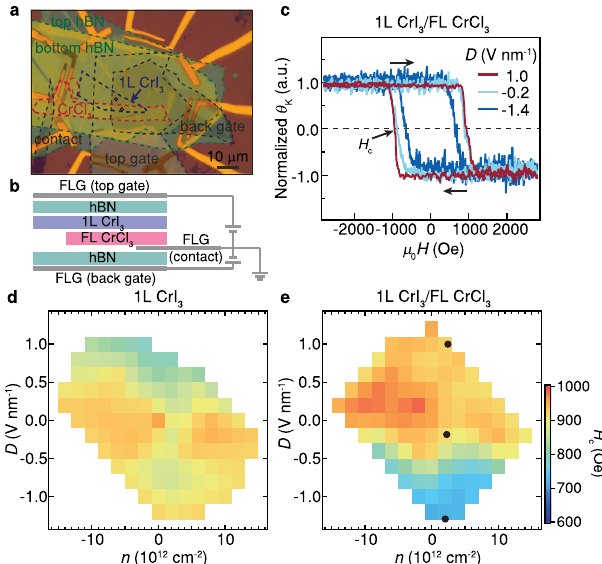
Fig. 3 | Electricalcontrolofthe magnetism in 1L CrI 3 /FL CrCl 3 heterostructure. a , b Optical micrograph and schematic structure of a dual-gated 1L CrI 3 /FL CrCl 3 device. Three few-layer graphene (FLG) fl akes are used as back/top gates and the contact to the stack. c Normalized MOKE signal as a function of perpendicular magnetic fi eld in 1L CrI 3 /FL CrCl 3 heterostructure under different displacement fi elds D = − 1.4, − 0.2, 1.0Vnm − 1 . Coercive fi eld H c as a function of electrostatic doping density n and displacement fi eld D of 1L CrI 3 ( d ) and 1L CrI 3 /FL CrCl 3 het- erostructure( e ),respectively.Theblackdotsin e correspondtotheMOKEcurvesin c . The data are taken at the spots marked by red in a